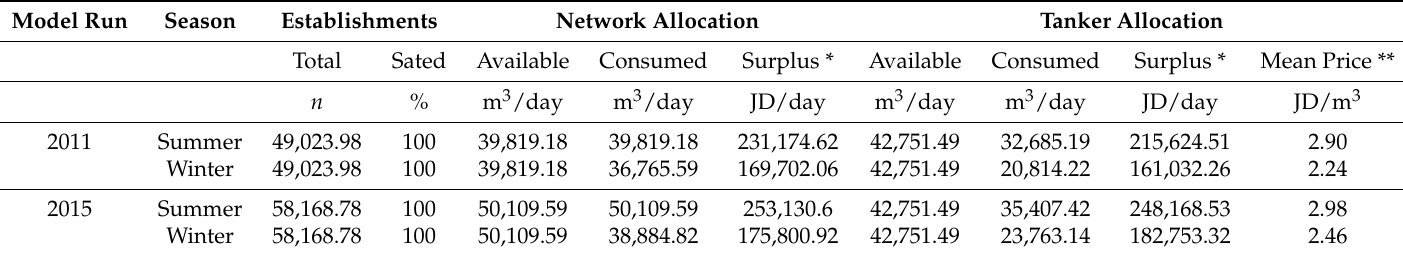
Table A3. Selected model outputs across all model